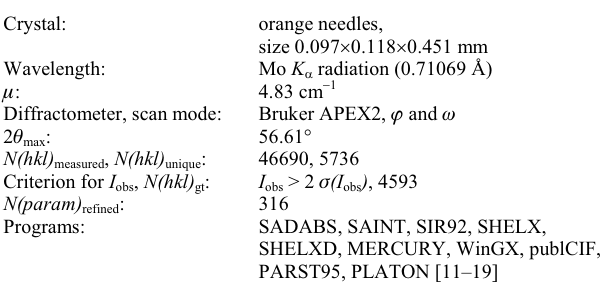
Table 1. Data collection and